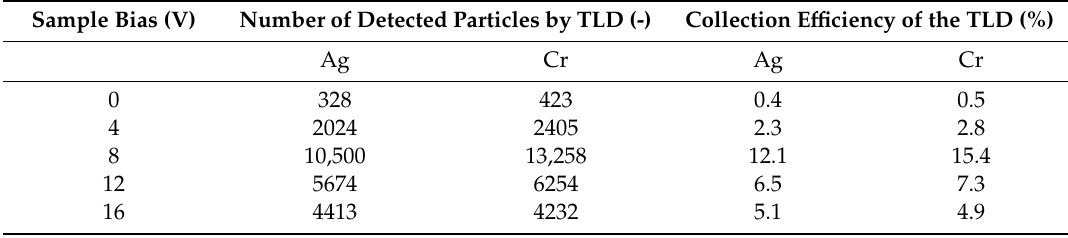
Table 4. Simulated results for the specimen Ag / Cr; the number of traced particles of Ag, as well as Cr, is 86,756 and 86,027,